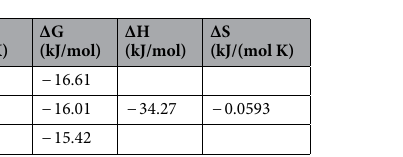
Figure 7. ( a ) Linear fitting for the thermodynamic parameters for the Sb(III) sorption onto GAD. ( b ) Adsorption–desorption cycle of GAD.